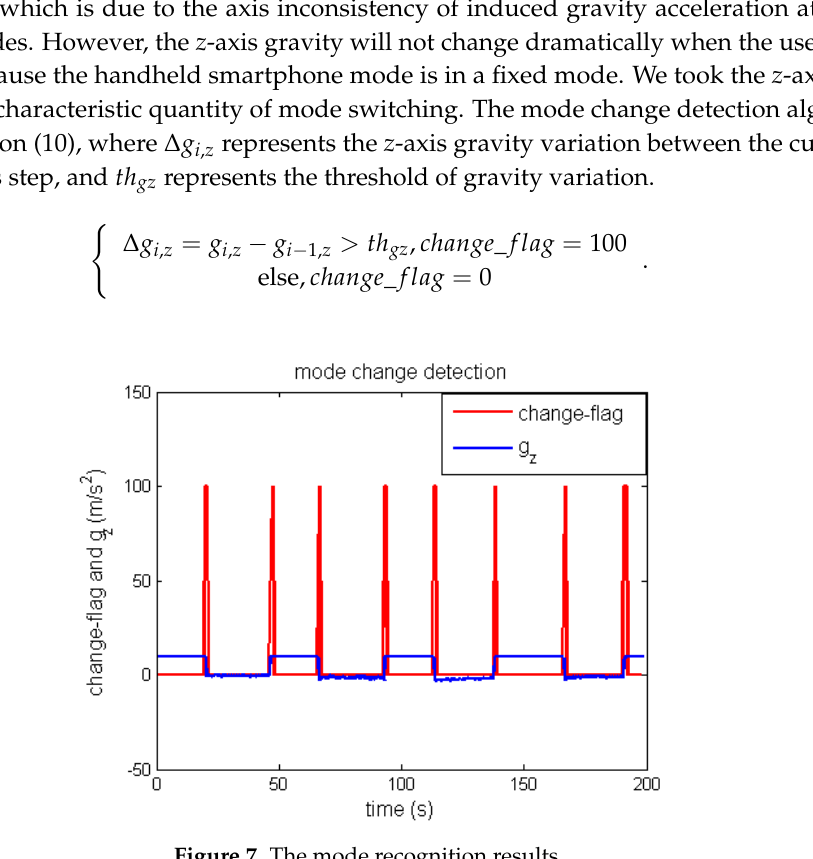
Figure 7. The mode recognition results.